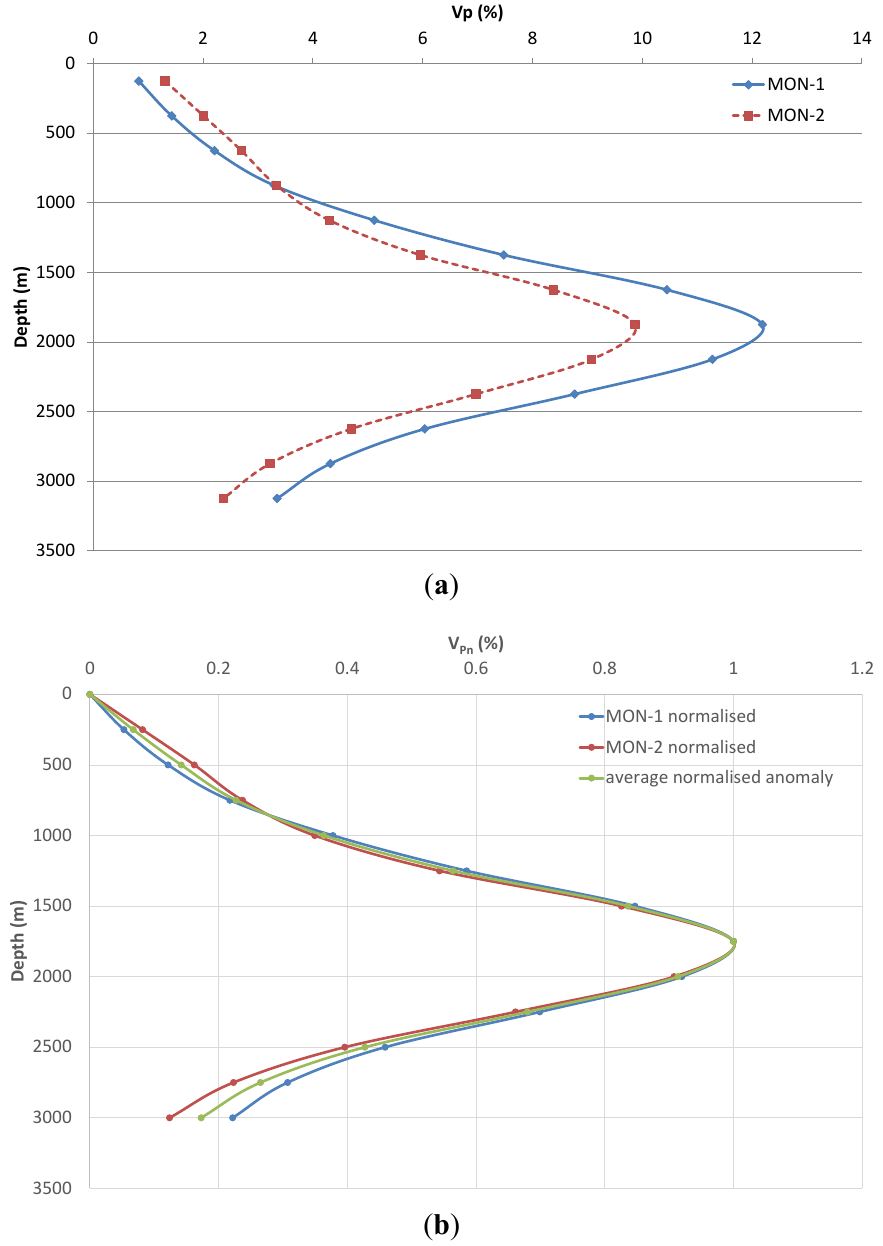
Figure 3. ( a ) Tomographic inversion result at position of MON-1 and MON-2 (% perturbation from mean velocity at each depth; sign reversed); ( b ) Seismic velocity anomalies for MON-1 and MON-2 have been normalised. The average of the two normalised anomalies is also